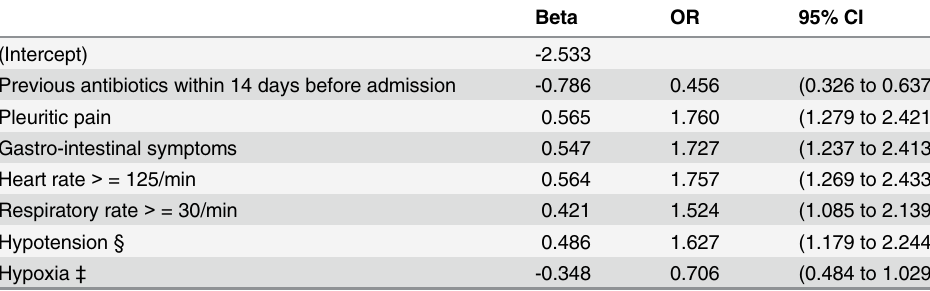
Table 3. Model without laboratory results of predictors independently associated with